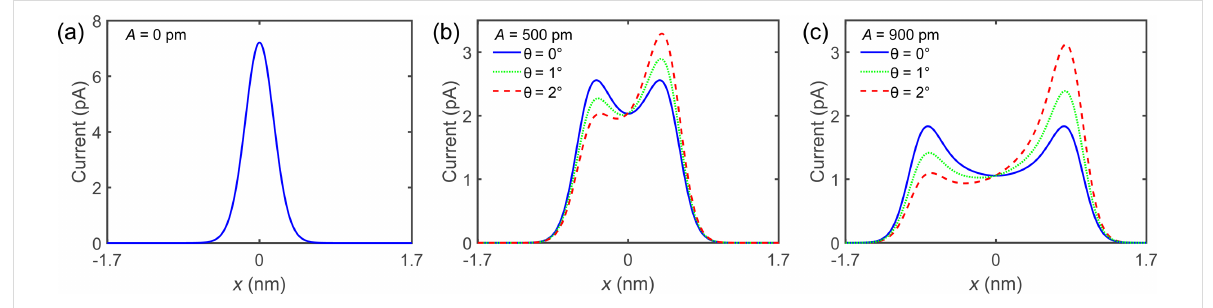
Figure 3: Simulating the effect of a laterally oscillating tip with different amplitudes and tilt angles on the STM signal. (a) With no oscillation. (b) With an amplitude of 500 pm and θ = 0°, shown by the blue solid curve, θ = 1°, shown by the green dotted curve, and θ = 2°, shown by the dashed red curve. With increasing oscillation amplitude, two peaks evolve, which differ in height in dependence on the tilt angles. (c) With an amplitude of 900 pm and θ = 0°, displayed by the blue solid curve, θ = 1°, displayed by the green dotted curve, and θ = 2°, displayed by the red dashed curve. With a higher oscillation amplitude the difference between the two peaks